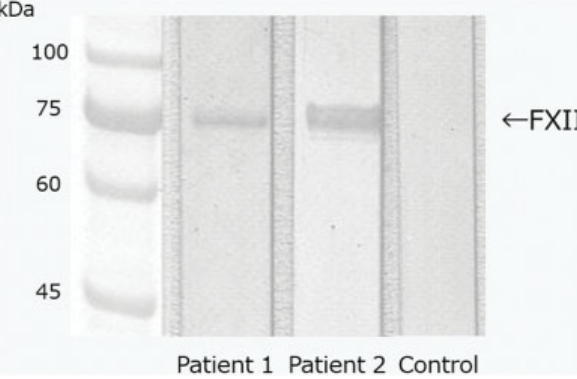
Fig. 5. Binding of ASQ41-bound autoantibodies puri fi ed from